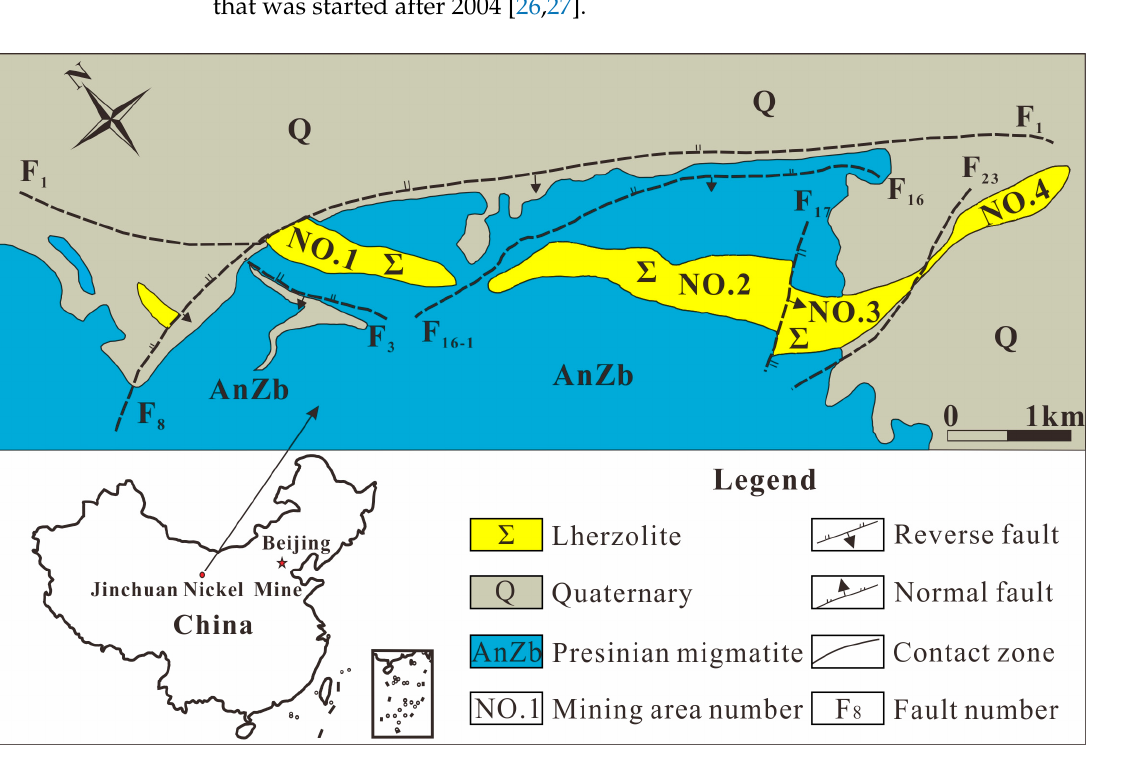
Figure 1. Location and geological map of Jinchuan Nickel Mine in China.